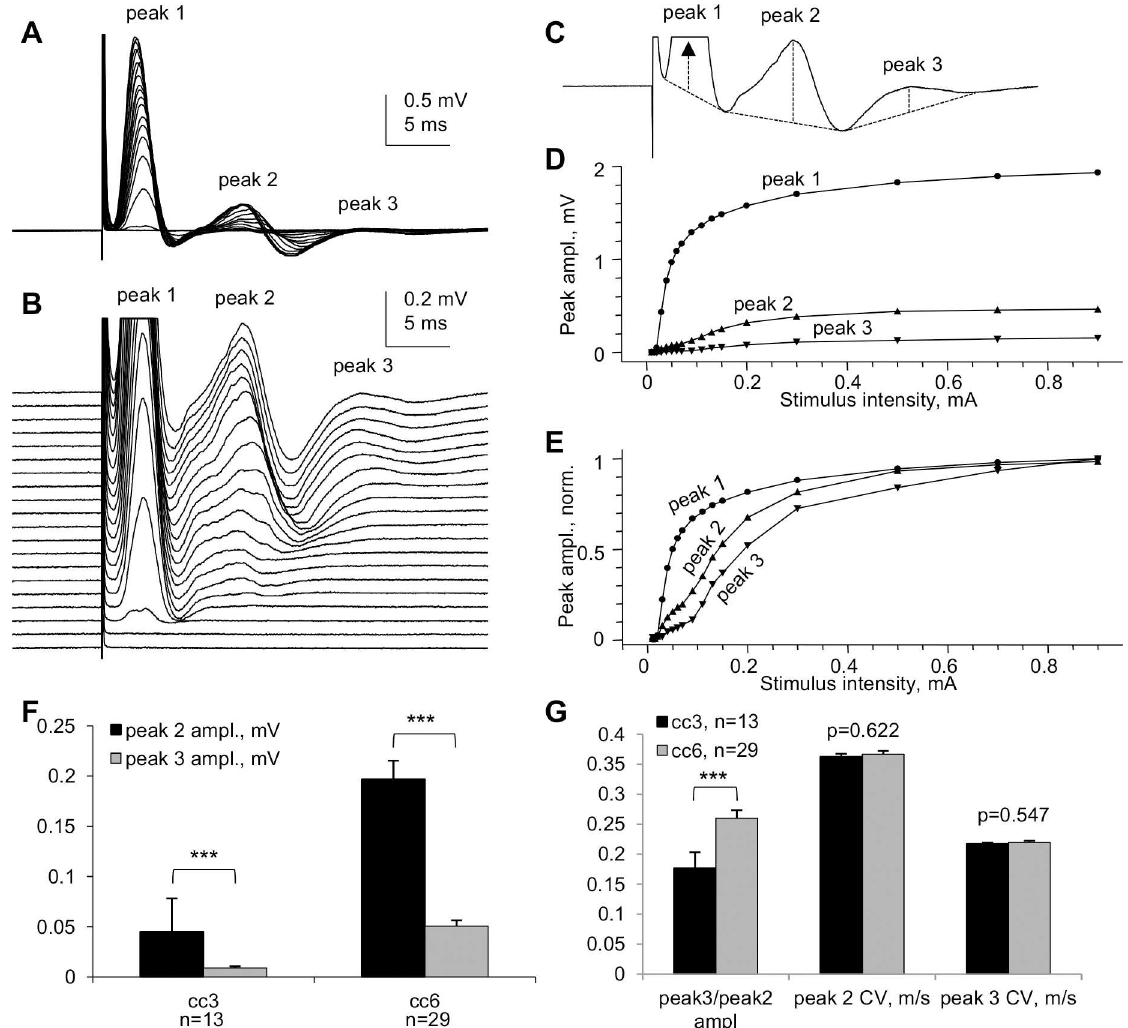
Fig 9. A third peak of “whole” CC CAPs. (A) Superimposed CAPs evoked by varyingstimulationintensitiesin an experimenton CC6. (B) Same traces as in (A), shown at highergain and separated vertically to illustrate the pattern of appearance of peak 3 at higherstimulationintensities. Each trace in A and B represents an averageof 6 consecutive recordingstaken at 10 s intervals. (C) Top (maximal) CAP from (B); dashed lines explainthe measurement of the amplitudes of peaks 1, 2 and 3 from their projected bases. (D–E) Stimulus–responseplots of the amplitudes of peaks 1, 2 and 3 shown in absolute(D) and normalized (E) values to illustratedifferent thresholdsof CAP peaks, and specifically the higherthresholdof peak 3 comparedto peak 2. (F) Statistical comparisonof the amplitudesof CAP peaks 2 and 3 in CC3 and CC6. (G) Comparison of peak3/peak2 amplituderatios (peak3/ peak2ampl) and conductionvelocities(CVs) of peaks 2 and 3 in CC3 and CC6. Room temperature. *** p <